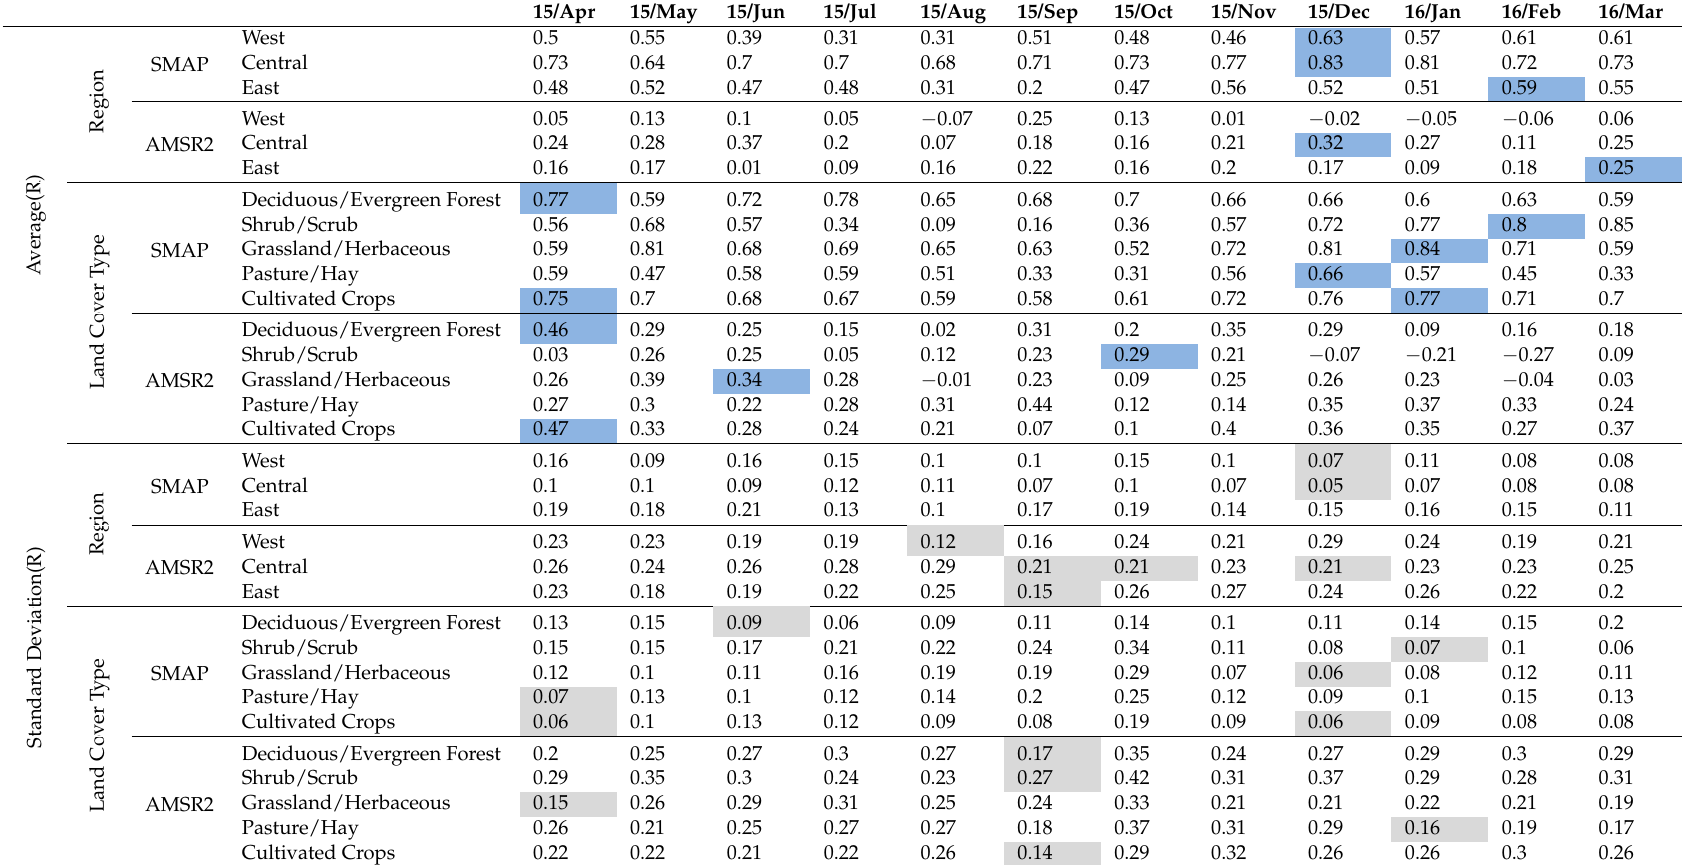
Table 2. Average correlation and standard deviation of correlation for SMAP L4and AMSR2 L3 daily average soil moisture retrievals against in situ observations (R) (The highlight blue data are the largest Mean value of R and the highlight gray data are the lowest Standard Deviation value of